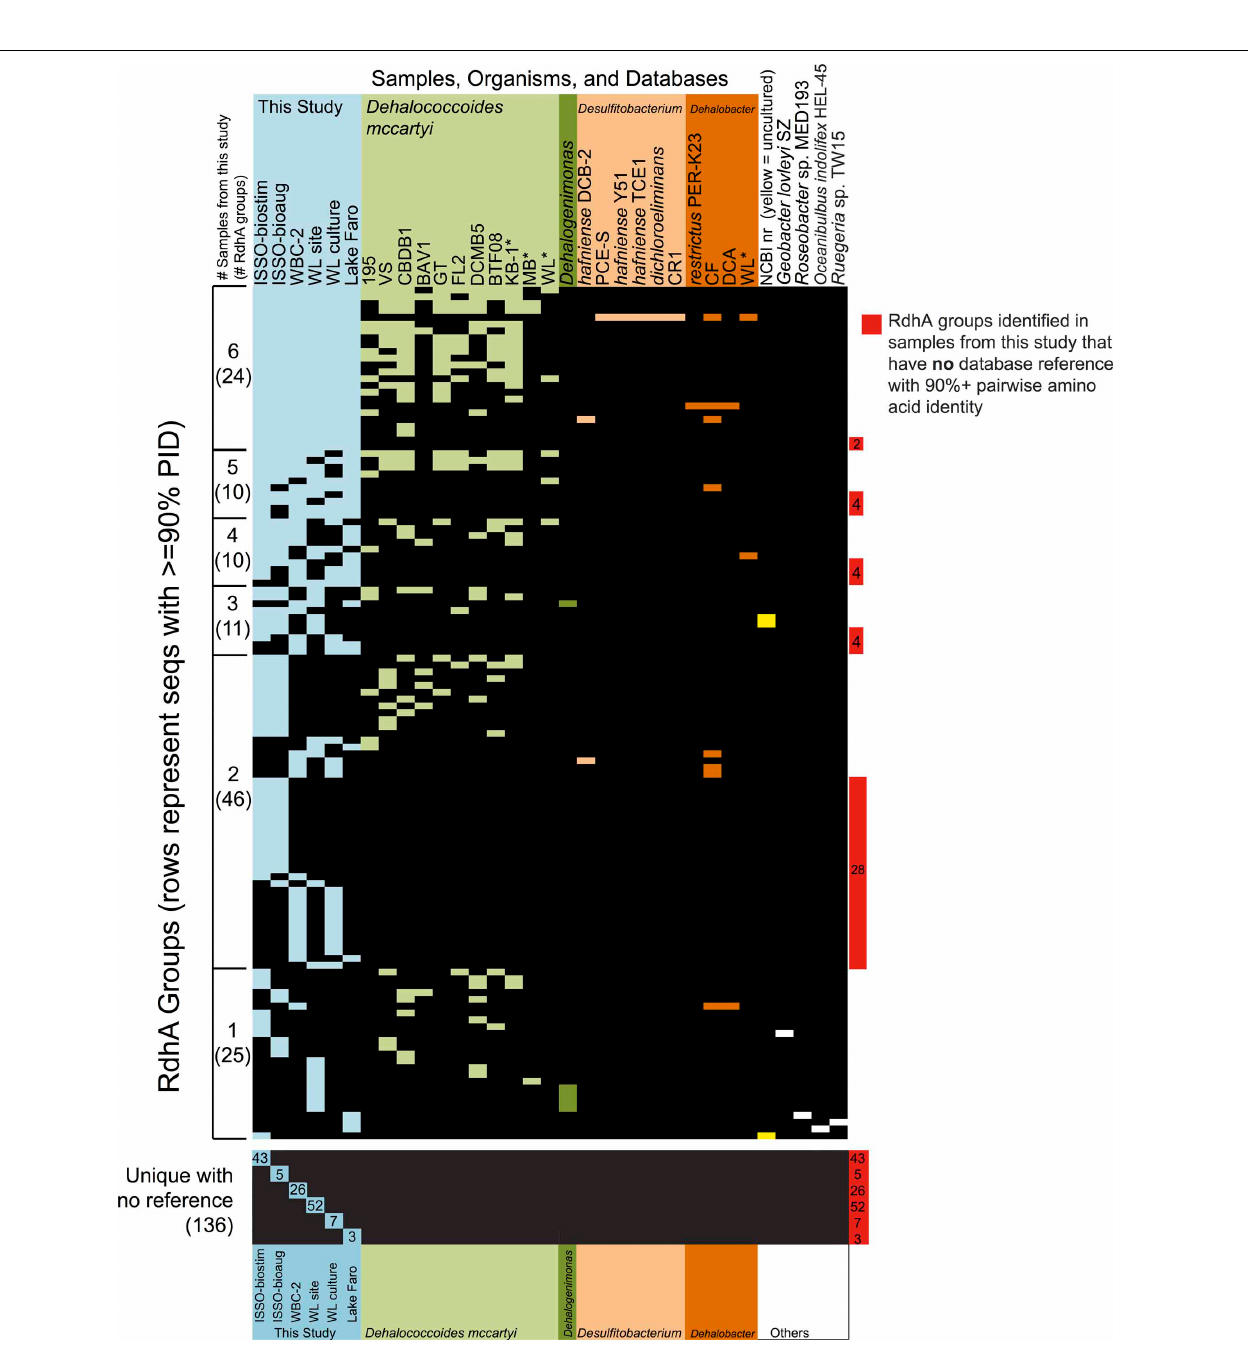
blue, isolate genomes and characterized mixed microbial consortia (e.g., WL and KB-1) included in the original primer suite reference set are colored by phylum, and reference genomes not included in the reference set are in white. Groups containing only sequences identified in this study are highlighted in red on the right. Cases where the sole homolog to a new RdhA sequence is an NCBI database sequence from an uncultured bacterium are marked in yellow within the NCBI nr column. Asterisks note enrichment cultures for which RdhAs have been identified, but for which the full complement of RdhAs may not be fully determined at this time. Accession numbers and further group information is available in supplemental Table S4